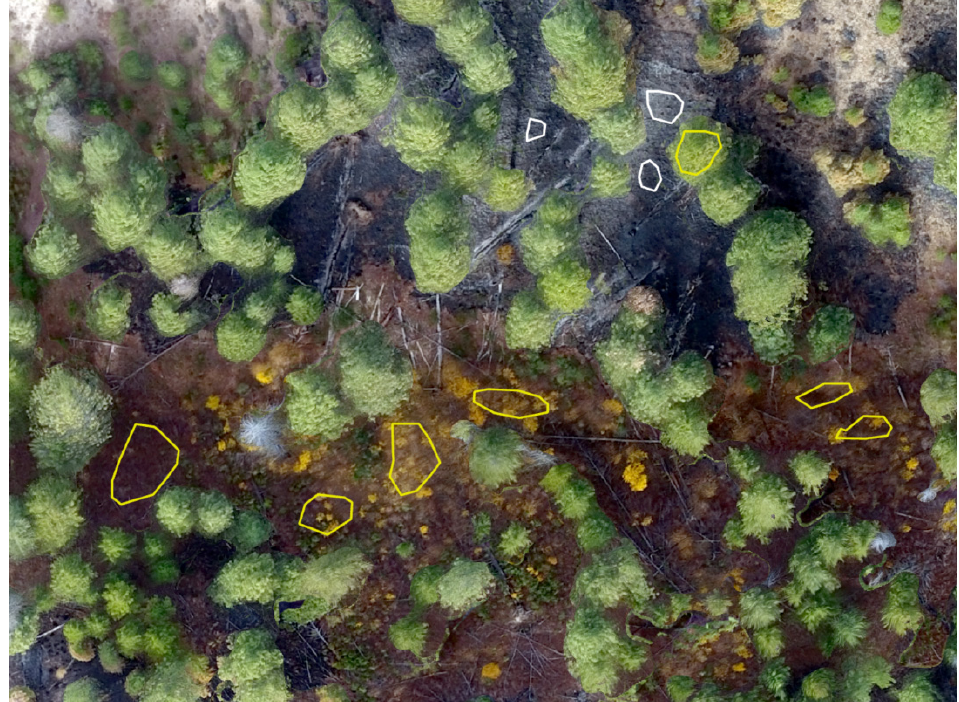
Figure 1. Example of data used to train SVM. Polygons in white were drawn to classify the pixels as burned, and polygons in green were drawn to classify the pixels as unburned. burned, and polygons in green were drawn to classify the pixels as